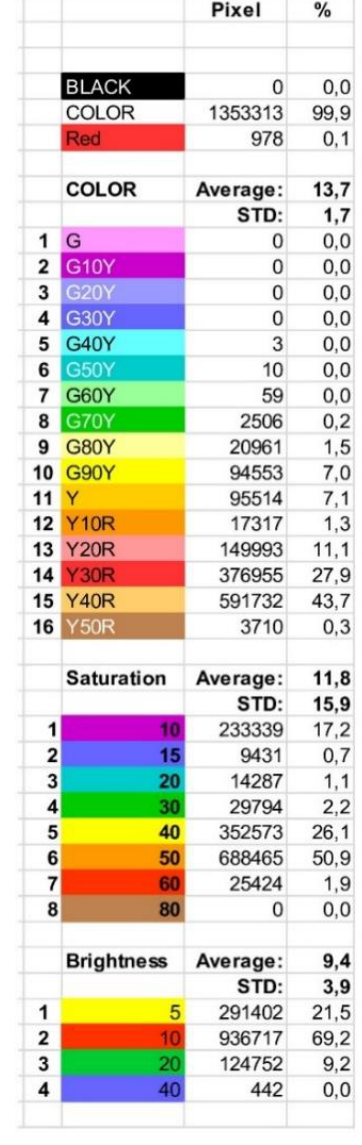
Figure 7. Mango color results as provided by the software WinFoodEval. List of color tones and codes according to the HSI classification. (This is a zoom from Figure 6).